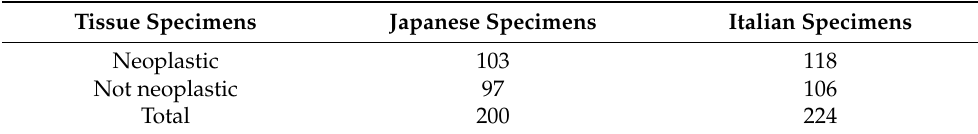
Table 1. Japanese and Italian specimens collected and analyzed by PESI-MS. Tissue Specimens Japanese